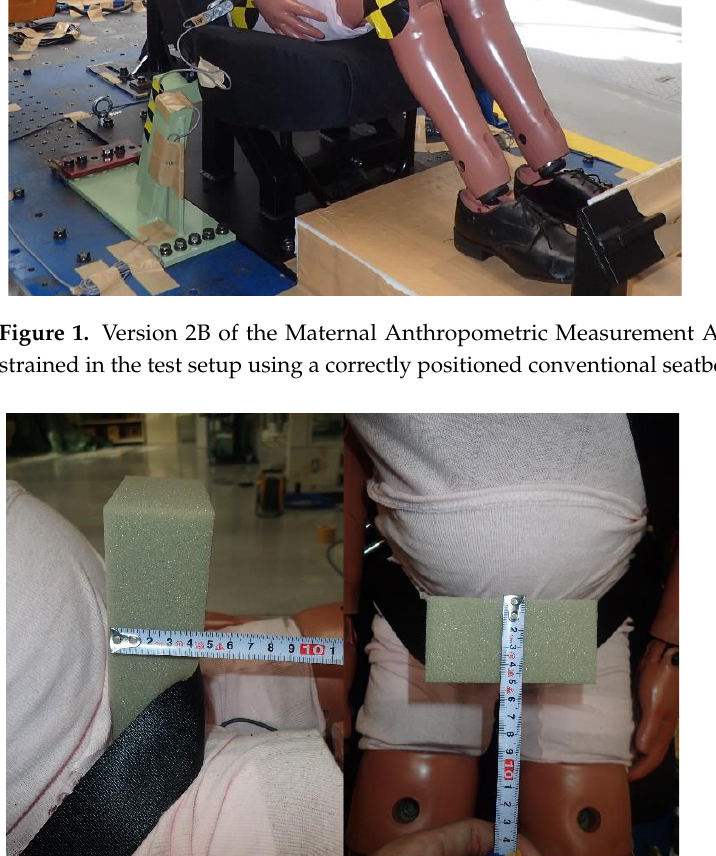
Figure 3. Test setup of the MAMA-2B dummy with the lap belt passed across both thighs and an- chored between them using an extra restraint device.